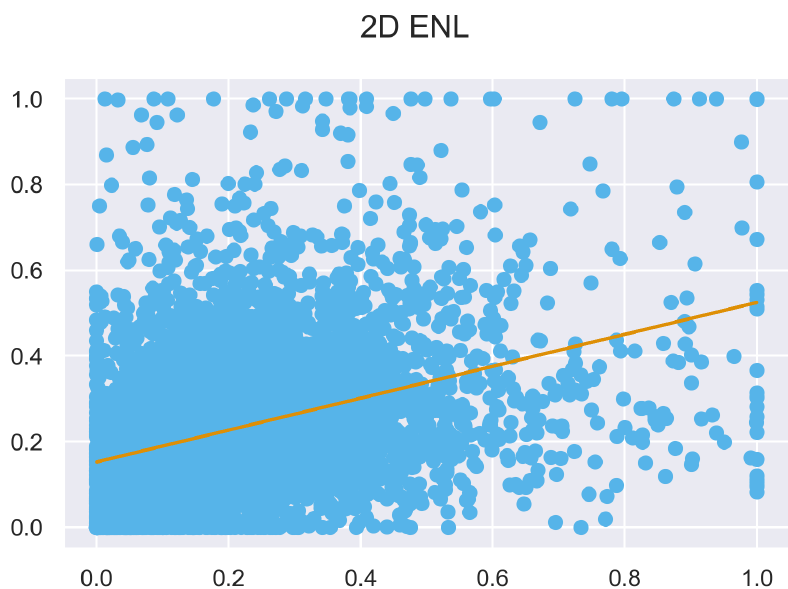
Figure A25. ULS and TLS 2 D ENL regression at 1m grid